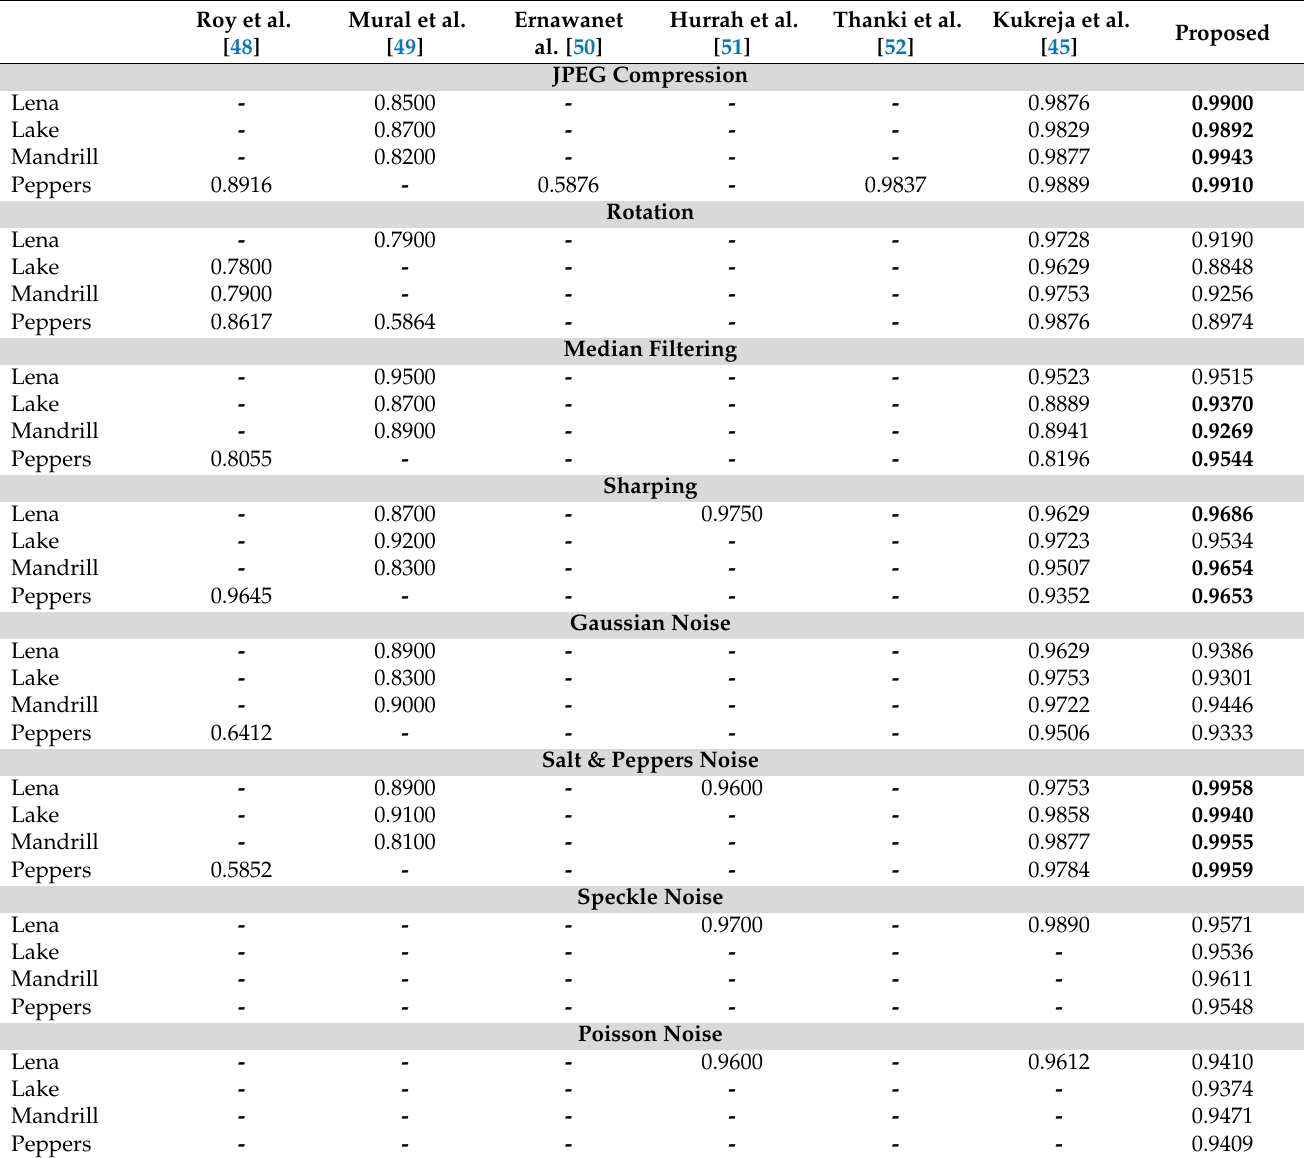
Table 7. Quantitative comparison of the proposed approach with the state-of-the-art